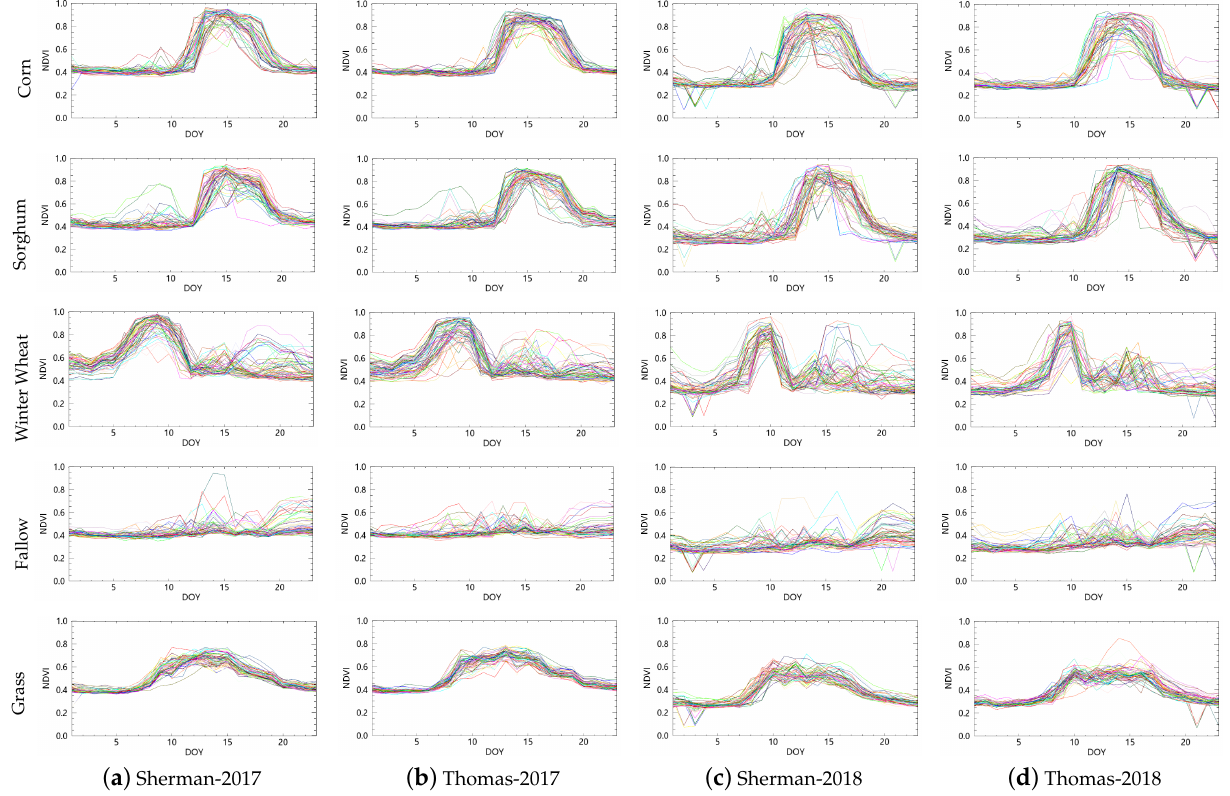
Figure 2. MODIS NDVI time series. Different colored lines represent the NDVI curves of different selected pixels in each subfigure. ( a ) NDVI time series of five crop classes at 60 pixels in Sherman County in 2017; ( b ) NDVI time series of five crops at 60 pixels in Thomas County in 2017; ( c ) NDVI time series of five crops at 60 pixels in Sherman County in 2018; ( d ) NDVI time series of five crops at 60 pixels in the Thomas County in 2018. Although these pixels were extracted from relatively pure pixels in the study areas, the time series curves still demonstrate the strong growth pattern variabilities in all crop types, especially in winter wheat. Moreover, the growth trends of different regions and different years for the same crop also have inevitable differences. The corn and soybean, which are both summer crops, have confusing phenological periods. These inner-class variabilities, inter-class similarities, and spatial/temporal discrepancies impose big challenges on crop type separation and spatial and temporal generalization capabilities of